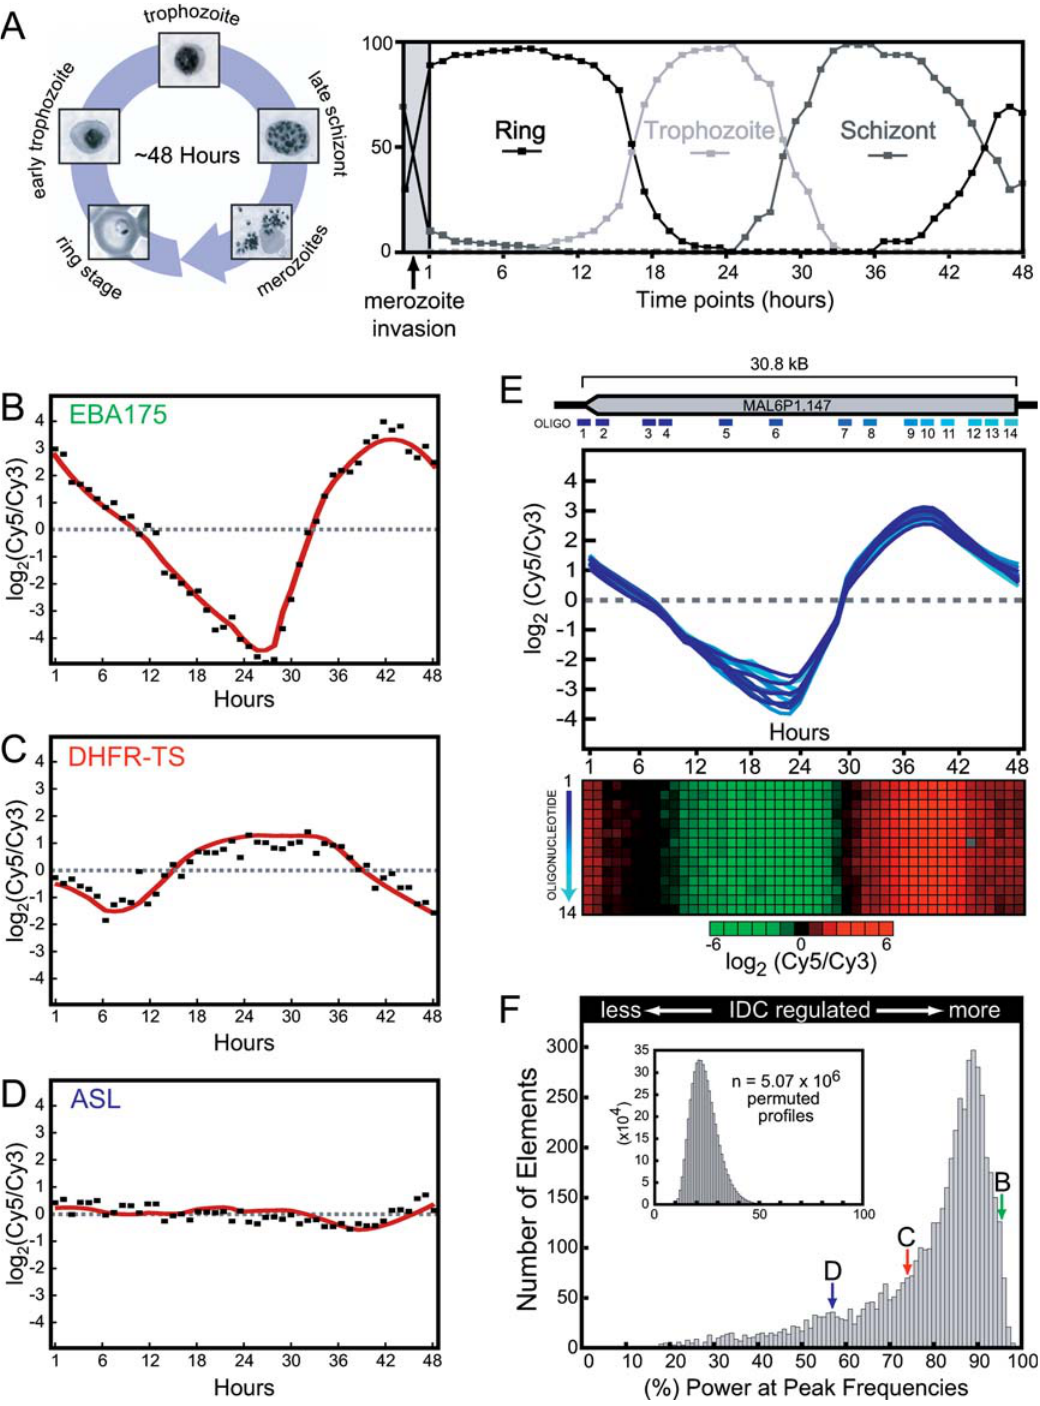
Figure 1. Parasite Culturing and Data Characteristics of the P. falciparum IDC Transcriptome Analysis (A) Giemsa stains of the major morphological stages throughout the IDC are shown with the percent representation of ring-, trophozoite-, or schizont-stage parasites at every timepoint. The 2-h invasion window during the initiation of the bioreactor culture is indicated (gray area). (B–D) Example expression profiles for three genes, encoding EBA175, DHFR-TS, and ASL, are shown with a loess fit of the data (red line). (E) MAL6P1.147, the largest predicted ORF in the Plasmodium genome, is represented by 14 unique DNA oligonucleotide elements. The location of each of the oligonucleotide elements within the predicted ORF and the corresponding individual expression profiles are indicated (oligo 1–14). A red/green colorimetric representation of the gene expression ratios for each oligonucleotide is shown below the graph. The pairwise Pearson correlation for these expression profiles is 0.98 6 0.02. (F) The percentage of the power in the maximum frequency of the FFT power spectrum was used as an indicator of periodicity. A histogram of these values reveals a strong bias toward single-frequency expression profiles, indicating that the majority of P. falciparum genes are regulated in a simple periodic manner. This bias is eliminated when the percent power was recalculated using random permutations of the same dataset (inset). For reference, the locations of EBA175 (peak B), DHFR-TS (peak C), and ASL (peak D) are shown. DOI: 10.1371/journal.pbio.0000005.g001 PLoS Biology |